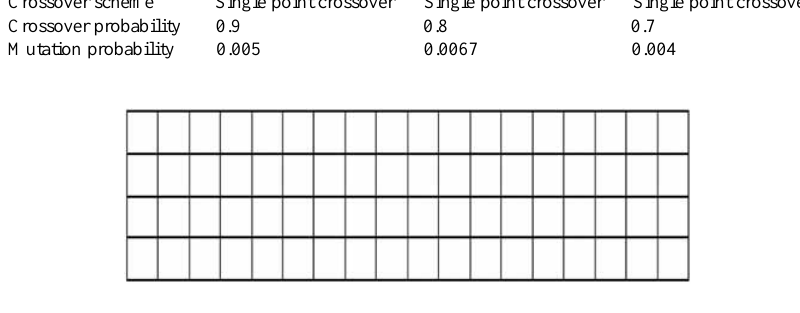
Fig. 14. Initial shape with refined mesh of the simply supported beam.